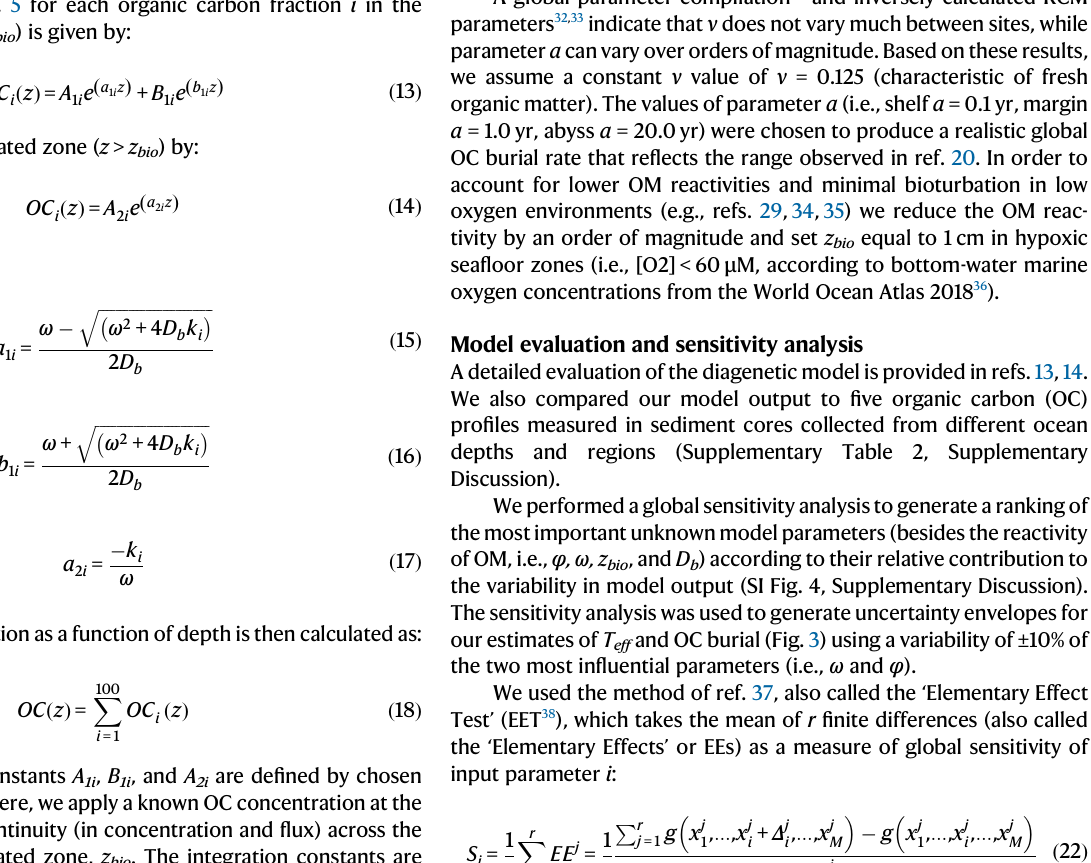
ffiffiffiffiffiffiffiffiffiffiffiffiffiffiffiffiffiffiffiffiffiffiffiffiffiffiffi (cid:6) (cid:7)q ω 2 +4 D b k i